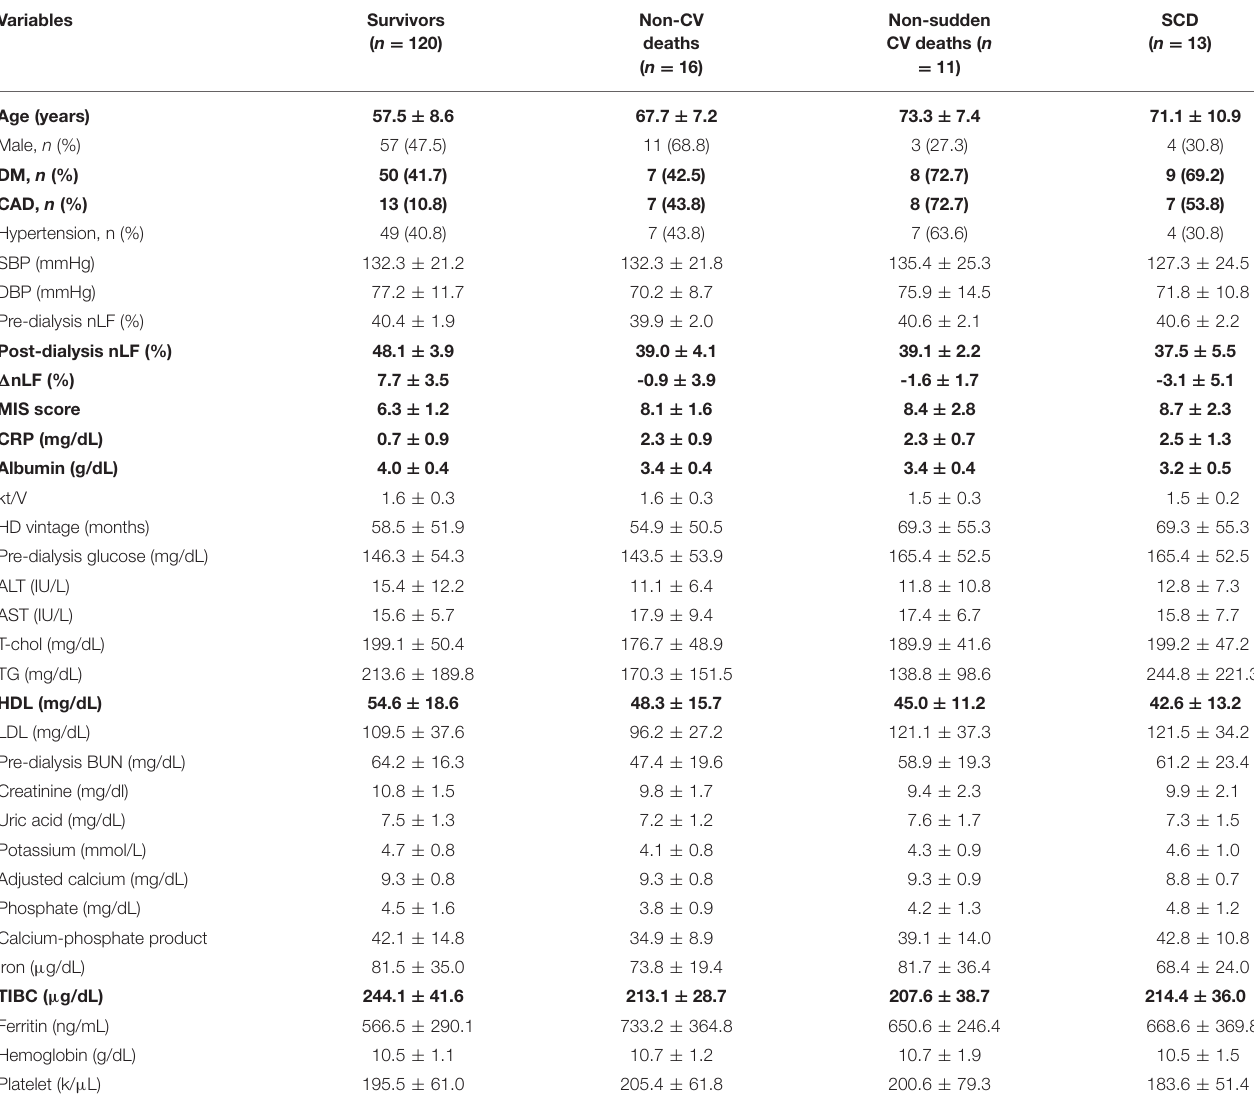
TABLE 2 | Comparison of demographic characteristics and relevant laboratory data among survivors, non-CV deaths, non-sudden CV deaths, and SCD.